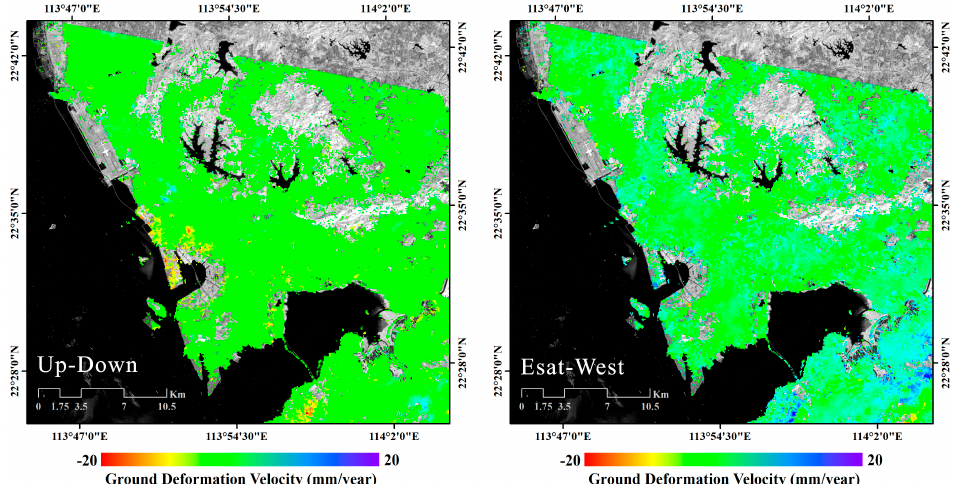
Figure 12. Shenzhen area results. Maps of Up–Down ( left ) and East–West ( right ) mean deformation velocities retrieved by the ascending and descending ENV deformation time-series obtained using the MinA method.